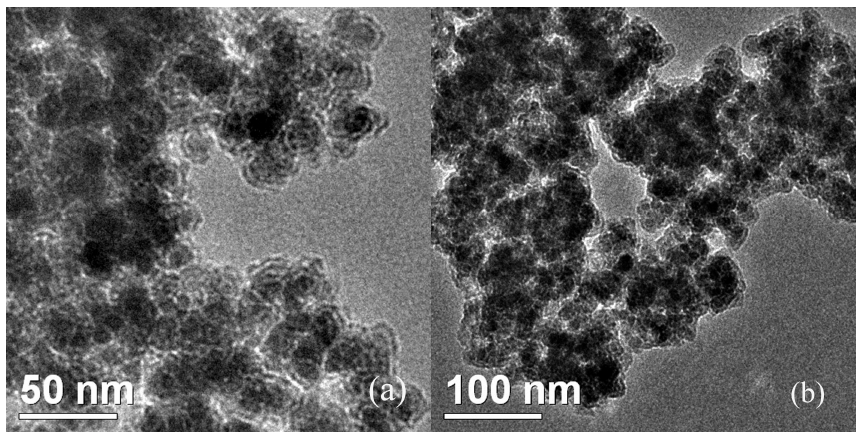
Figure 3. Transmission electron microscope (TEM) images of the recovered catalyst ( a ) and fresh catalyst ( b ).